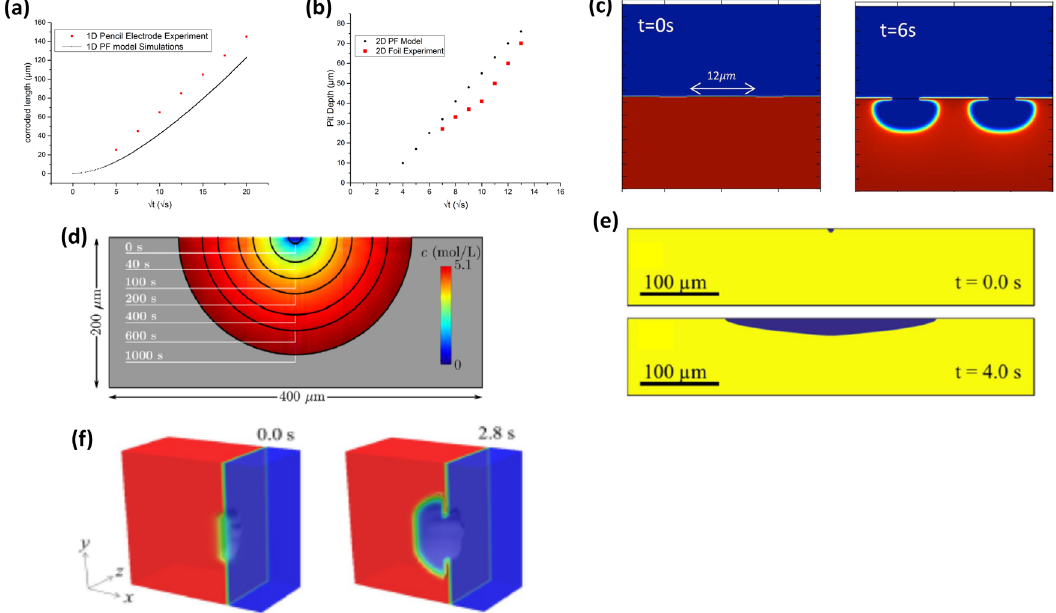
Fig. 1 Pitting corrosion without passivation kinetics. a , b Show the corrosion depth vs. the square root of time in 1- and 2-D simulations, respectively 67 . c Shows the growth of two individually growing pits without interaction in the presence of electrolyte (blue) 67 . d Depicts the pit depth and corresponding metal ion concentration as a function of time 64 . e Depicts pit growth in a 2-D geometry based on simulations by Chadwick et al. 71 . f Depicts 3-D simulations of pit growth in a corrosive electrolyte 72 . a , b are reproduced with permission from ref. 67 , published by nature springer in 2018. d Reproduced with permission from ref. 64 , published by Elsevier in 2016. e Reproduced with permission from ref. 71 , published by IOP in 2018. f Reproduced with permission from ref. 72 , published by nature springer in